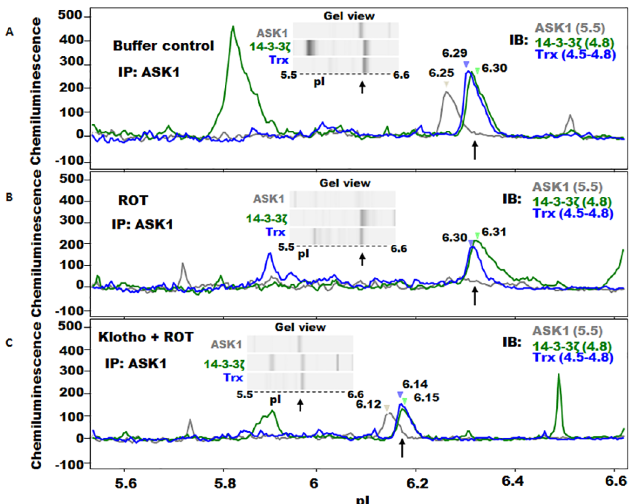
Fig 8. iCE analyses of ASK1 signaling complex interactions. Cells were either pretreated with buffer only or secreted Klotho for 40 min before adding 5 μ M ROT to induce oxidative stress. Clear lysates were co-IP with antibody against ASK1 and the eluted protein complex was subjected to immuno-CE fractionation as described in the text. (A) Immuno-CE profile of eluted complex of buffer-only-treated control cells originally separated within pH 4 – 8 ( p I range 5.5 – 6.6 is shown here for clarity) showing overlapping protein signals (arrow) within the p I range 6.25 – 6.30 comprising the ASK1/14-3-3 ζ /Trx complex assembly. Signals belonging to individual proteins dissociated from the triad were also found within the pH 4 – 8. Embedded is a software generated gel view of the complex within the specified p I range. Individual p Is of the proteins are indicated in parenthesis. (B) Profile of eluted complex from cells treated with ROT. Overlapping signals within p Is 6.29 – 6.30 (arrowed) are those of the 14-3-3 ζ /Trx complex. ASK1 signal was undetectable in the presence of ROT. Also shown is the gel view within the p I 5.5 – 6.6 range. (C) Profile of eluted complex from cells pretreated with secreted Klotho prior to ROT treatment. Overlapping signals within the p I 6.12 – 6.15